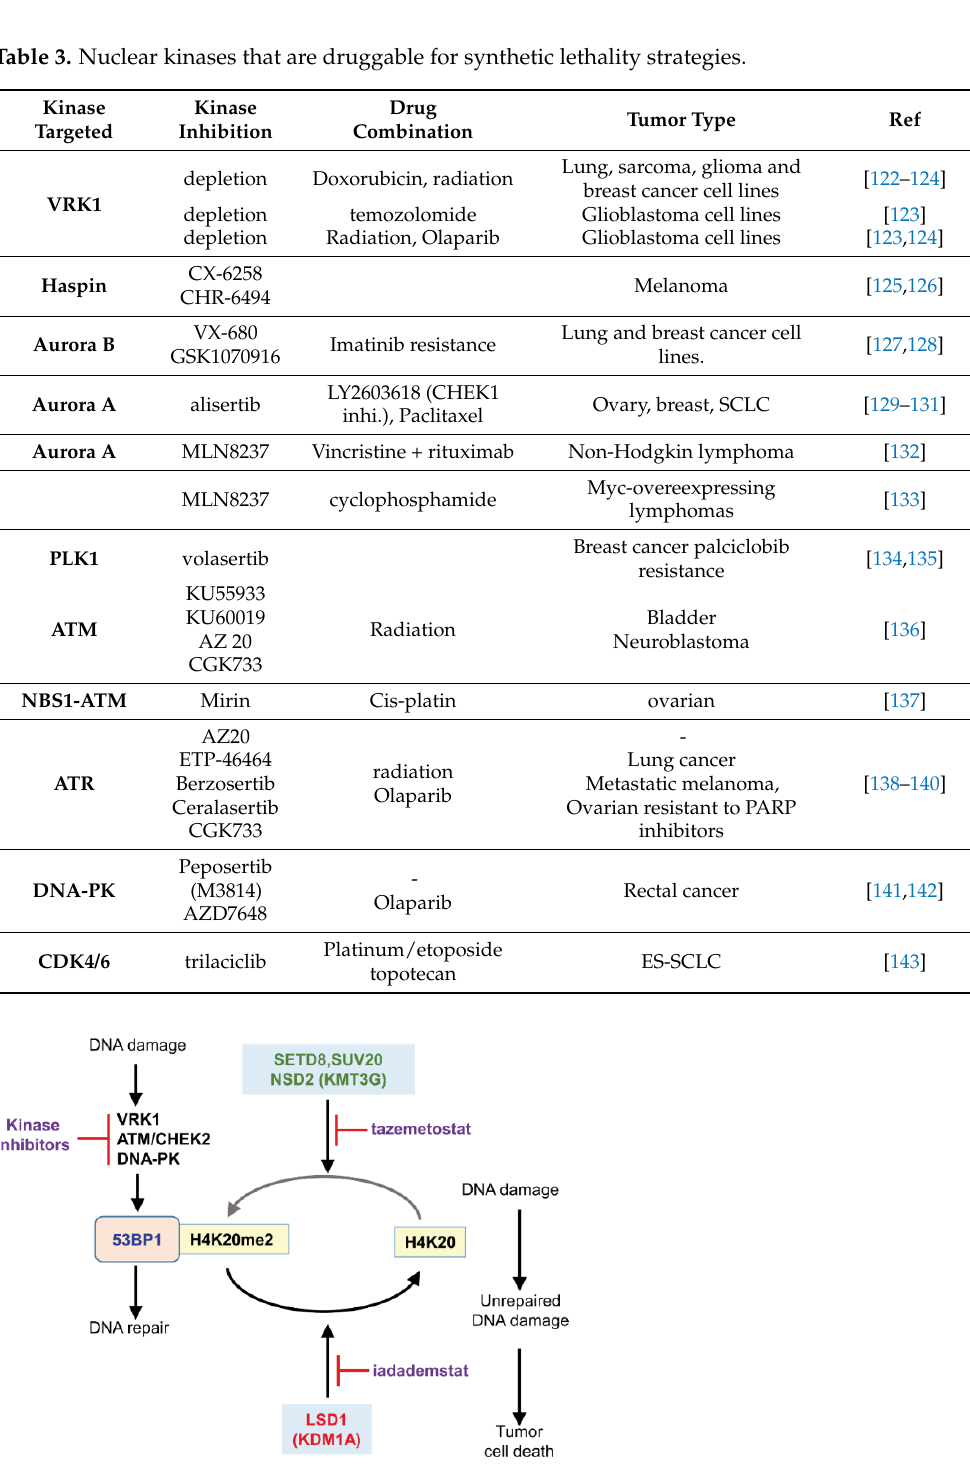
Figure 3. Effect methylation and demethylation inhibition on histone H4 in K20 and drugs that can alter the DNA damage response mediated by non-homologous end-joining pathway for which the dimethylation of H4K20 is required for recruitment of 53BP1.